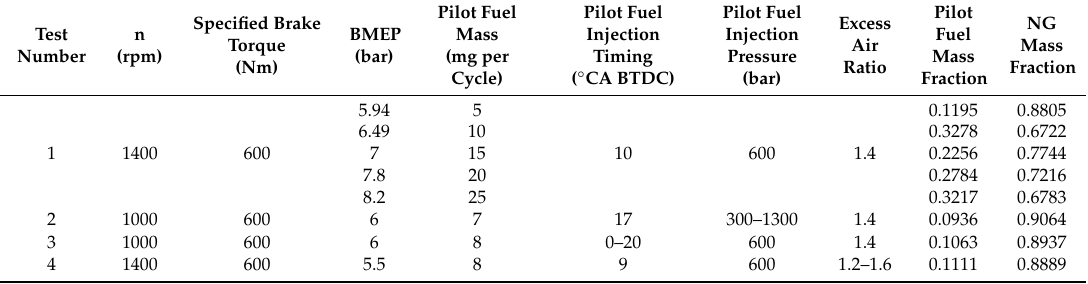
Table 3. Experimental conditions. BTDC, before top dead center; CA, crank angle; NG, natural